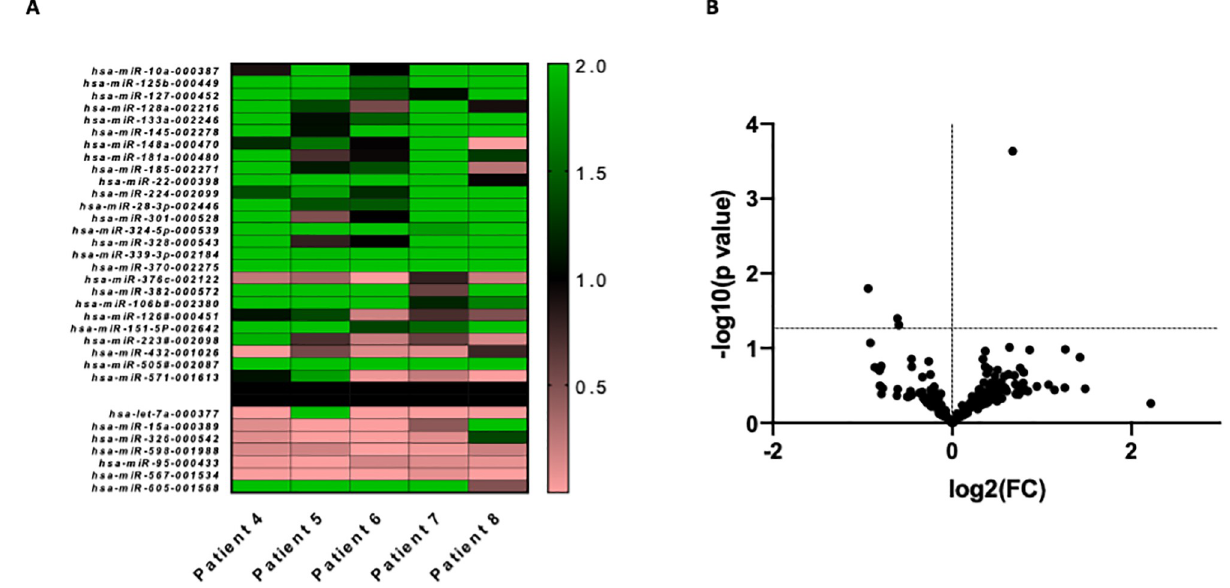
Fig 2. Micro RNA array from total blood RNA, n = 5. A heat map (shortened for better overview), B. Volcano plot.